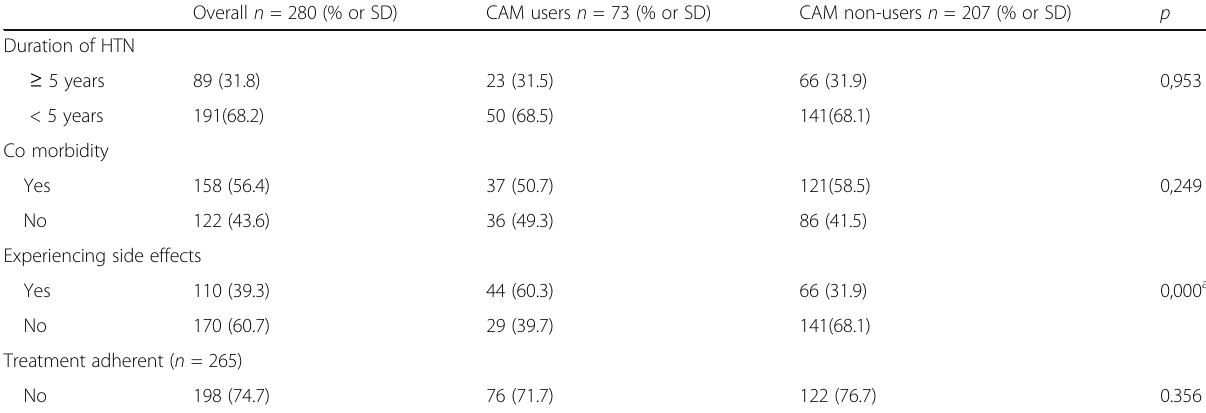
Table 5 Clinical characteristics of hypertensive patients using or not using CAM Overall n = 280 (% or SD)